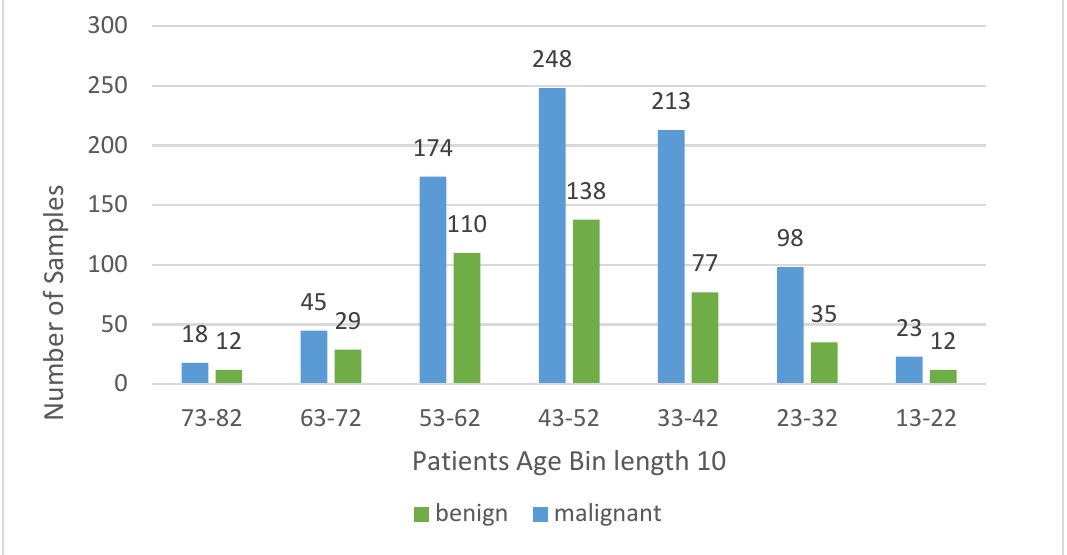
Figure 3. Distribution of patient age range according to patients’ nodule outcomes.